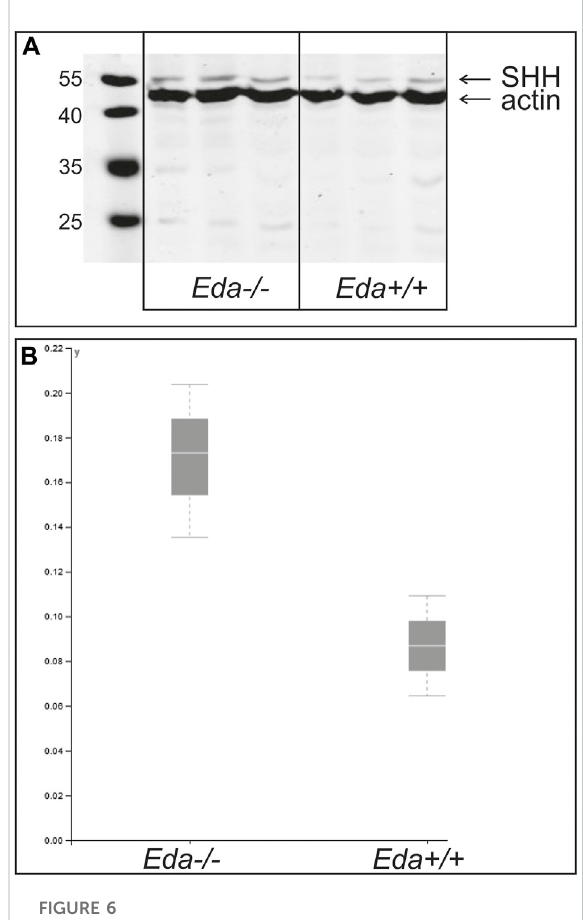
Relative amount of Shh protein at ED14.5 in Eda − / − and Eda+/+ mice. A representative WB experiment of three independent analyses is shown in the image (A) and graph (B) . Resulting images were scanned and protein quanti fi cation was performed using VisionCapt software. Intensity of bands was quanti fi ednormalizedtoactincontrol.Theanalysiswasperformed in three independent harvestings. The normality of the data was tested by Shapiro-Wilk test and consequently One Way ANOVA test was used to determine the differences of the relative protein levels in Eda − / − compared to control Eda+/+ . The differences of relative amounts of Shh protein quanti fi ed to the actin levels were not signi fi